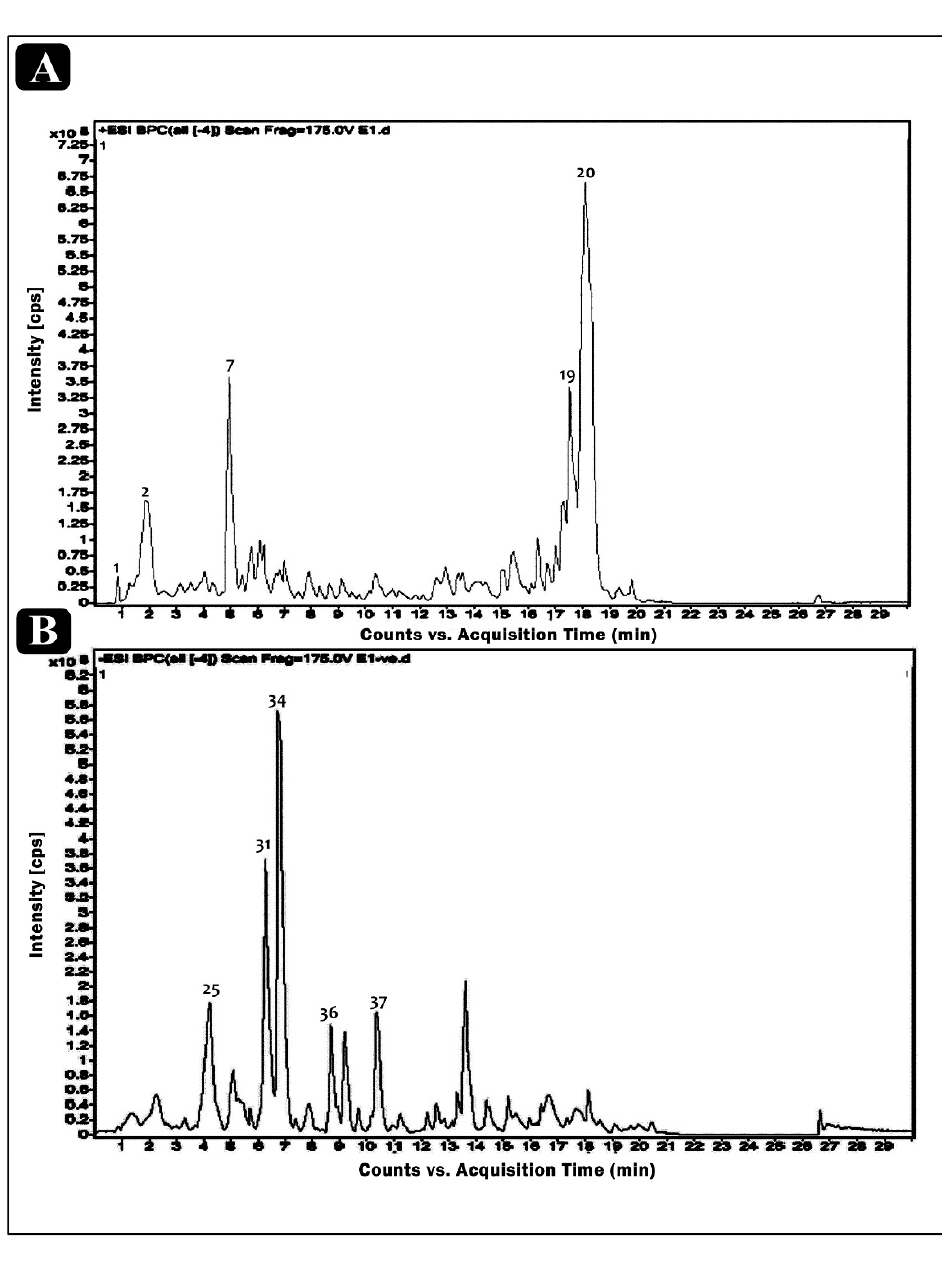
Figure 1. HR-LC/MS spectrum peak of E. sativa crude extract showing the chromatogram intensity against the acquisition time, ( A ) positive analysis and ( B ) negative analysis. Table 1. Identified tentative phytoconstituents from the ethanolic crude extract of E. sativa using HR-LC/MS.